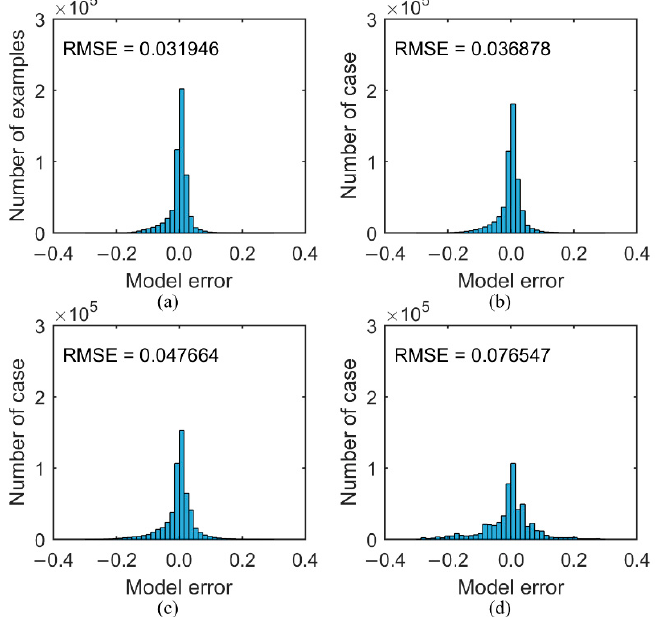
Figure 7. Analysis of inversion error of the ANN model for different surface reflectance noise. Four input surface reflectance noises were randomly assigned: ( a ) noise = 0.00; ( b ) noise = 0.01; ( c ) noise = 0.02; ( d ) noise = 0.05.